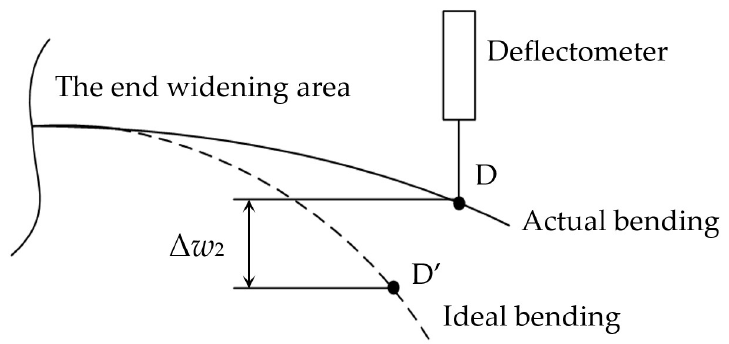
Figure 7. Deflection measurement error in the end widening area of an equal strength beam. To further observe the end measurement error, the ideal beam and the actual were numerically simulated in Ansys Workbench. A fixed load was applied at the loading point, and the deflection at different positions was taken at equal intervals at the end of the beam. The strain value was calculated by Equation (9). The results were shown in Figure 8. The result shows that the calculated strain value at the end of the actual equal strength beam is smaller than that of the ideal, i.e., the end measurement error is